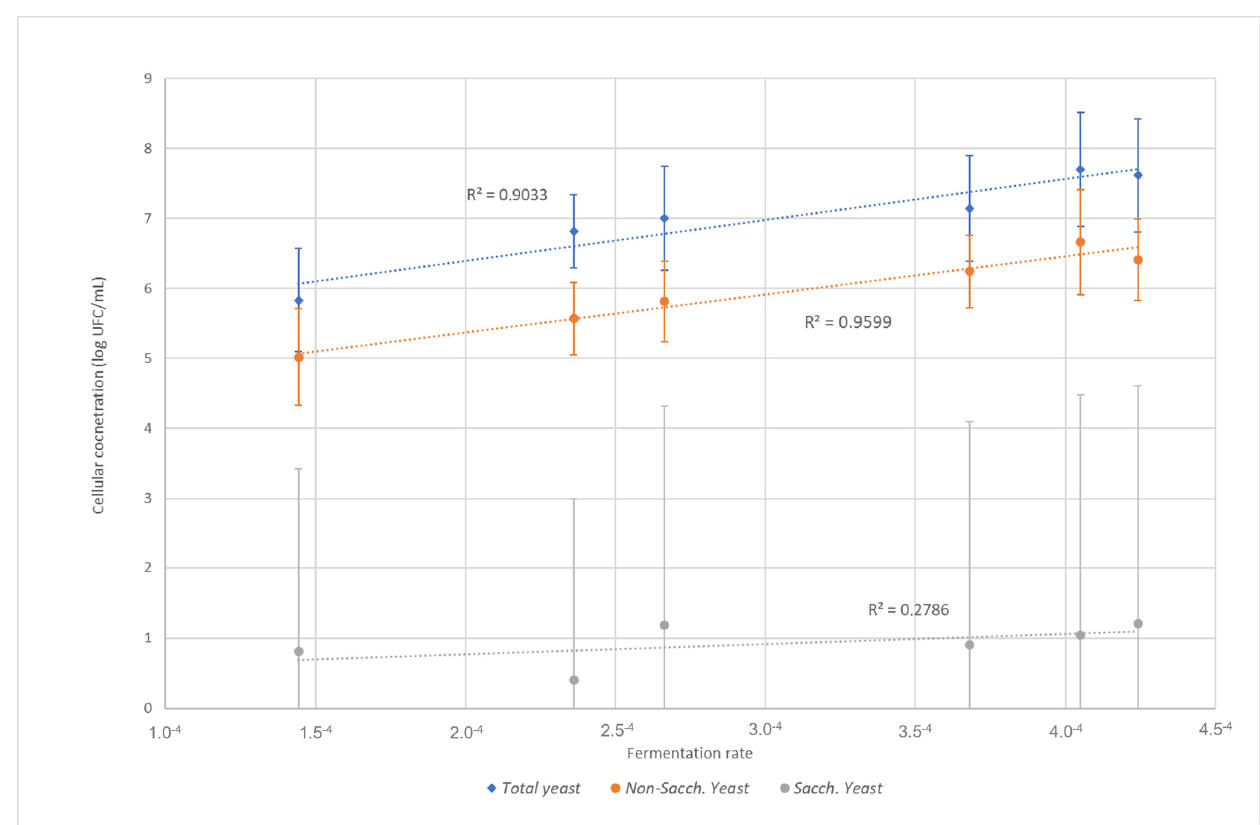
Figure 3. Correlation between the alcoholic fermentation rate and yeast cellular concentration in six points of observation (mean data, n = 6).